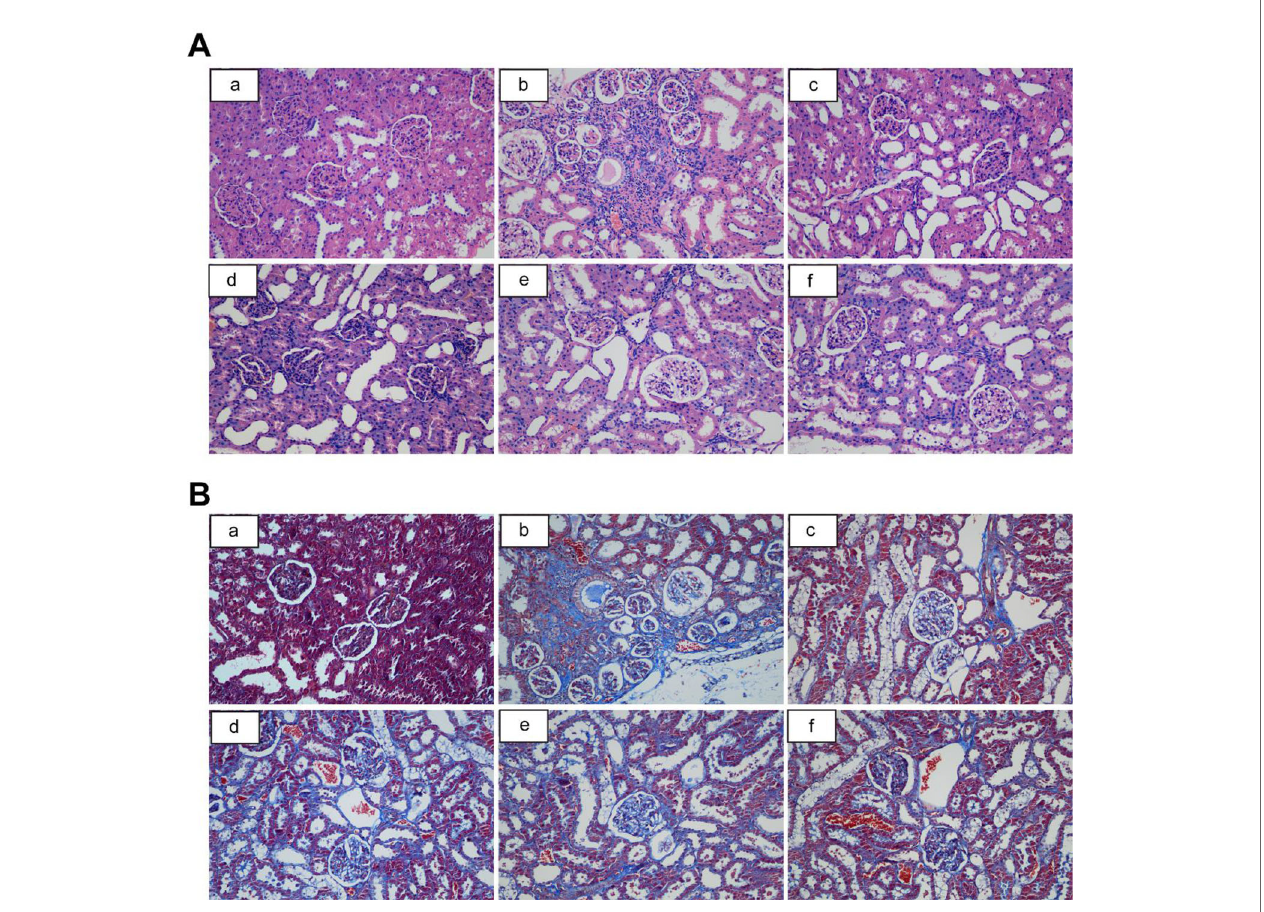
FIGURE 2 | EHF improved renal pathological features in DN rats. (A) H&E staining of renal tissues. (B) Masson staining of renal tissues. (a), control group (b), model group (c), positive group (d), EHF-L (e), EHF-M (f),